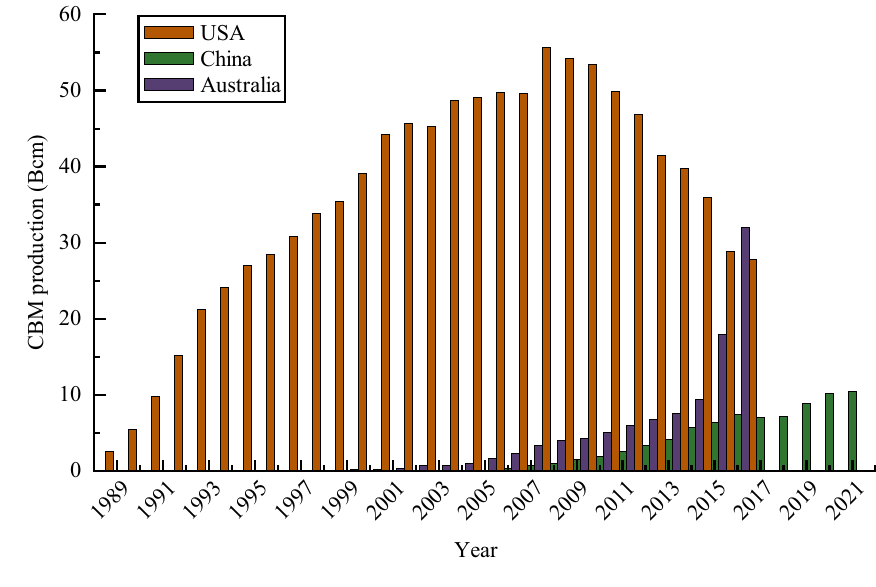
Fig. 1 Annual CBM production in the US, China and Australia, date from EIA (2022),